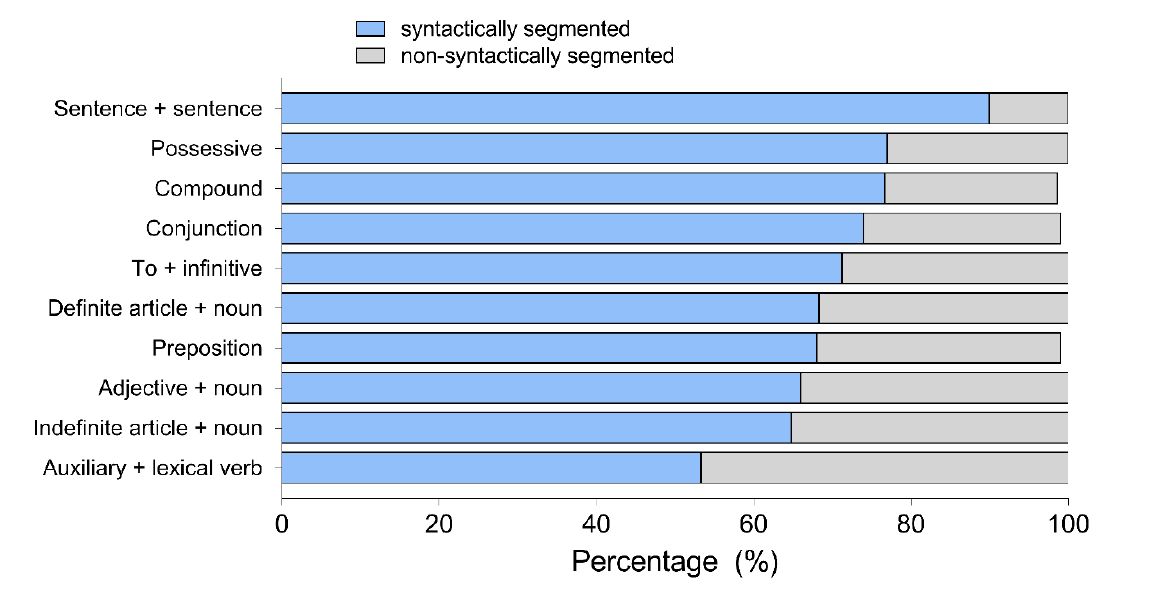
Figure 5. Preferences for SS and NSS subtitles by linguistic units in Experiment 2. Table 8. Percentage of Experiment 2 participants who preferred the syntactically segmented condition.